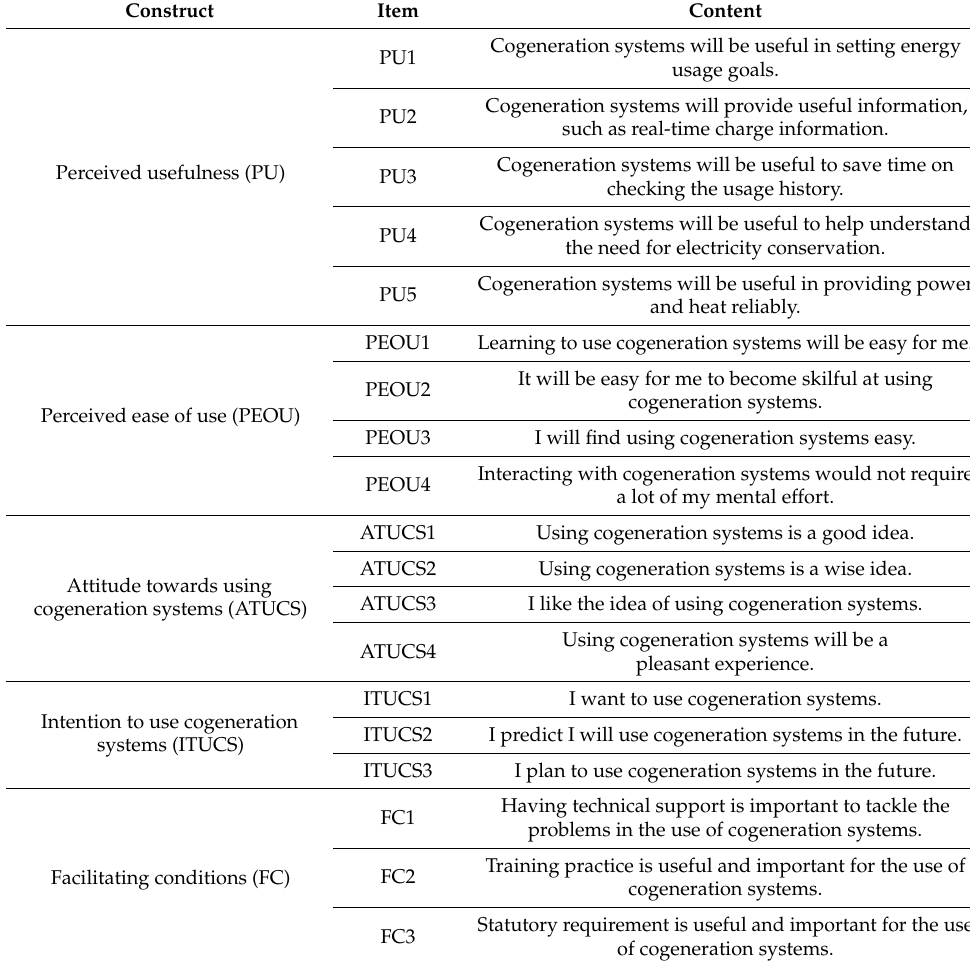
Table 1. Measurement of the